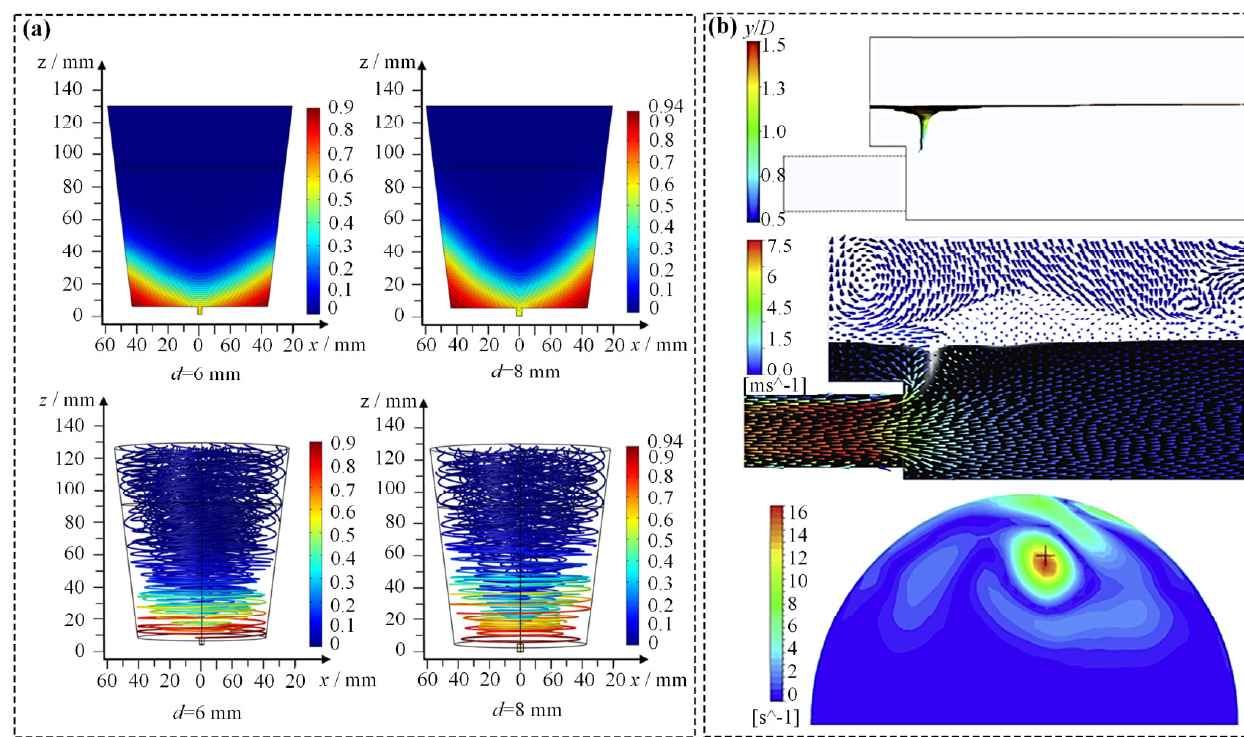
Figure 9. Interface evolution of a two-phase vortex. ( a ) Vortex evolution with different nozzle diameters. Reproduced with the permission of the General Iron and Steel Research Institute. (Reprinted with permission from Ref. [82]. 2017, Springer Nature.) ( b ) Vortex core, flow model, and vorticity distribution of the flow field. Reproduced with the permission of Elsevier. (Reprinted/adapted with permission from Ref. [83]. 2017, Elsevier.)